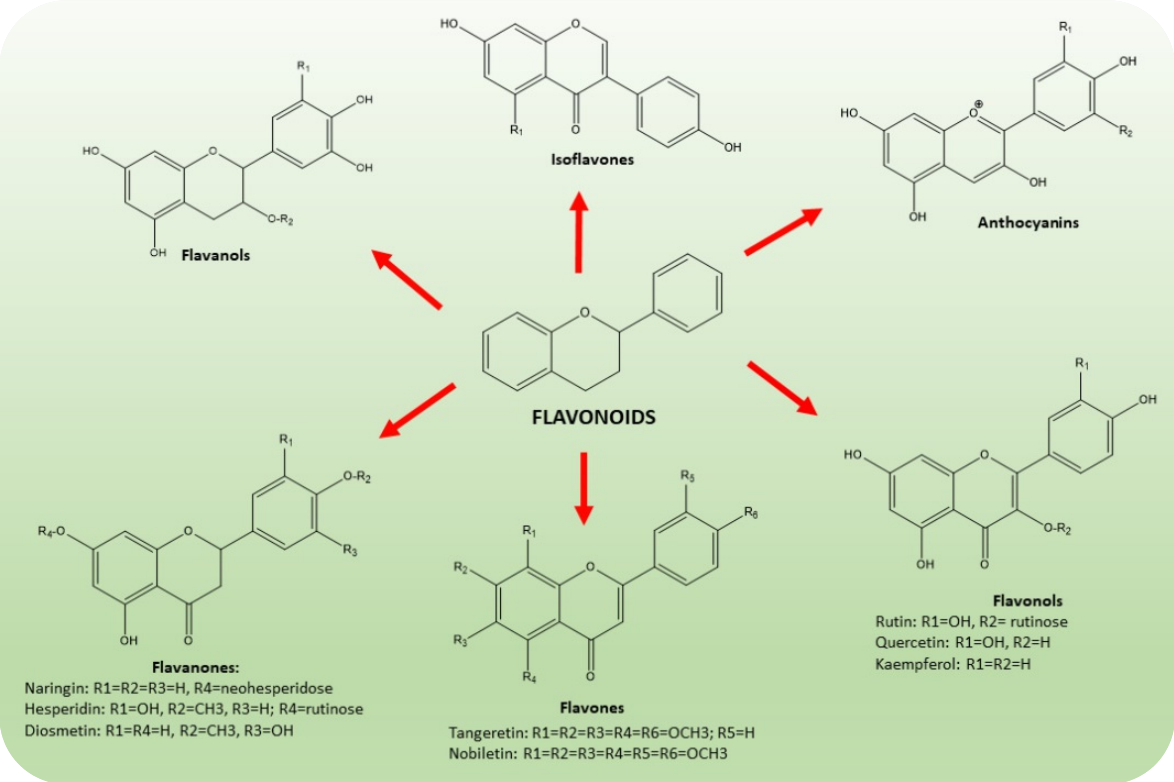
Figure 4. Chemical structures of the main classes of flavonoids present in CF, namely flavones, flavanones, flavonols, isoflavones, anthocyanidins and flavanols. The common scaffold of flavonoid class consists of a benzene ring joined to a benzo- γ -pyrone moiety.